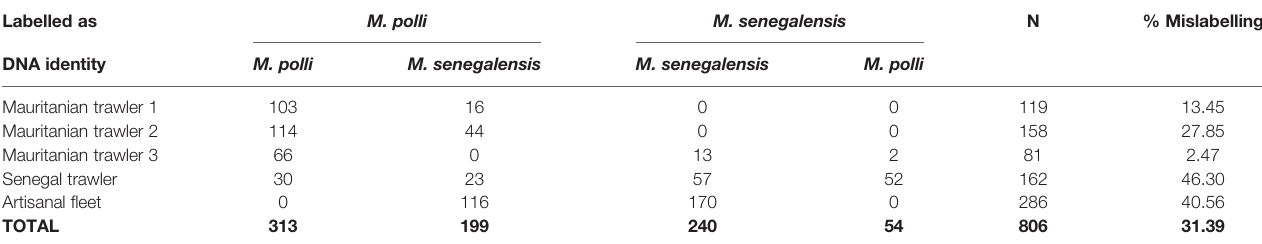
TABLE 2 | Multiple Logistic Regression with label categories as dependent variables, and haul depth and hake length as independent variables. Labelled as M . polli